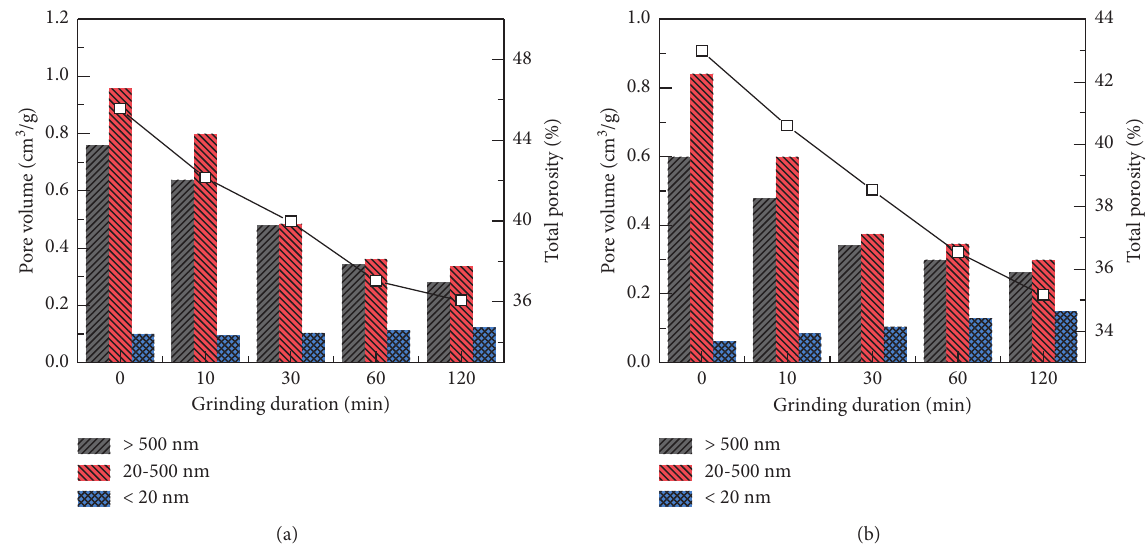
Figure 12: Pore structure of the samples after curing for 28d: (a) FA1 and (b)